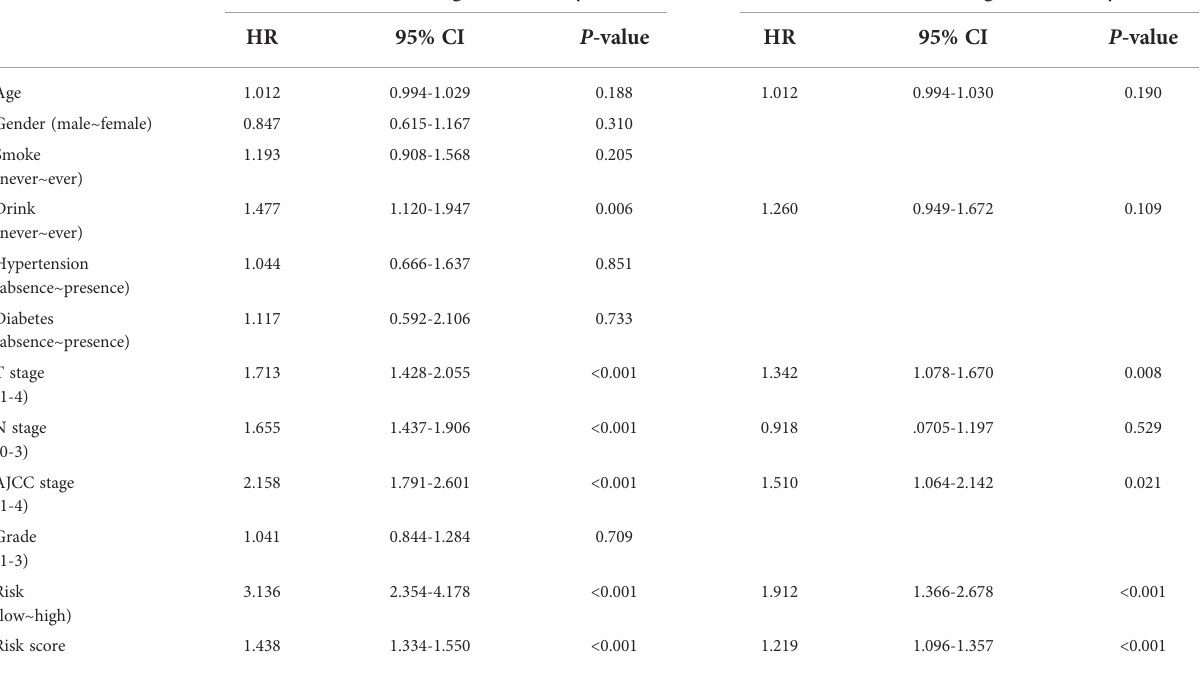
TABLE 2 Univariate and multivariate Cox regression analyses for survival.